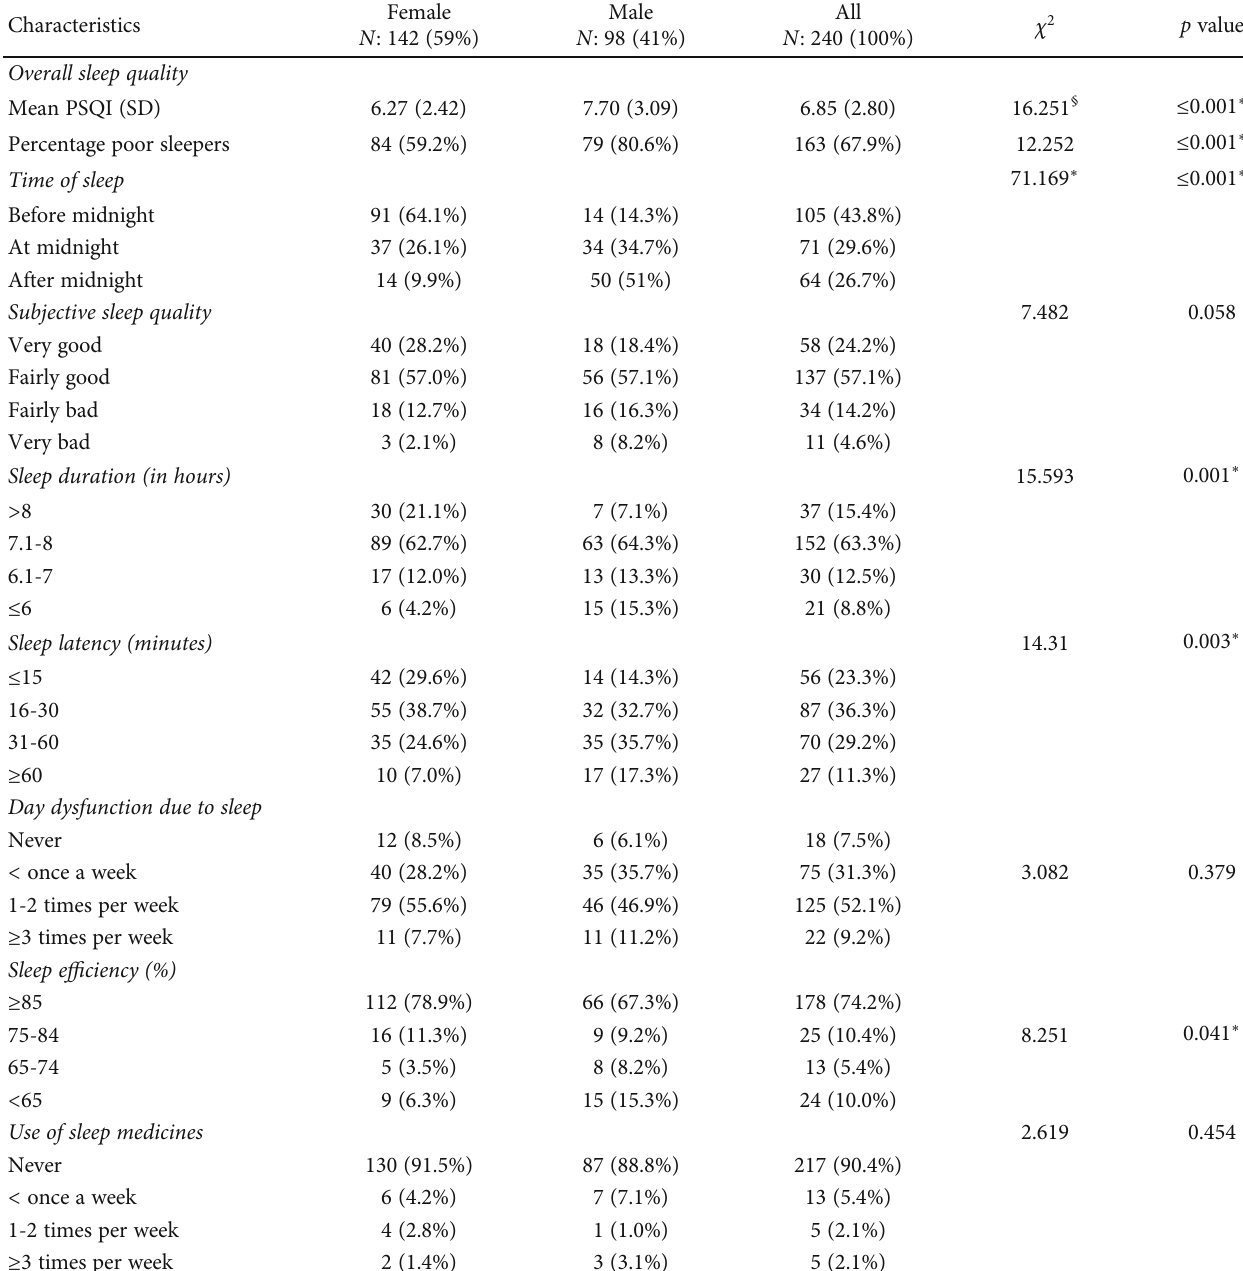
Table 3: Sleep quality and sleep patterns overall and strati fi ed by